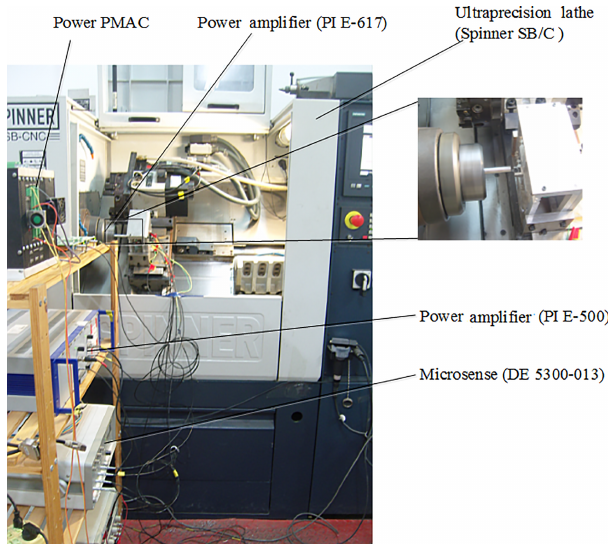
Figure 5. Cutting experiment of 3-D